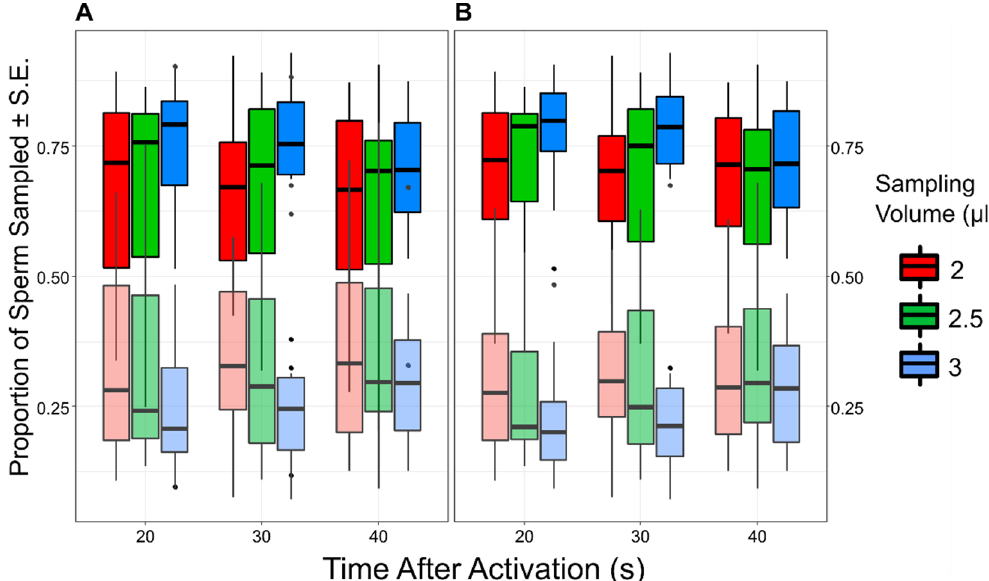
Figure 2. The boxplots show the proportion of sperm collected from the FRF (bright colors) and water (dull colors). Each box represents the value for a specific combination of time from activation (TA) and sampling volume (SV). In ( A ), the complete dataset is shown. In ( B ), data from trial 3 and 13 have been removed.